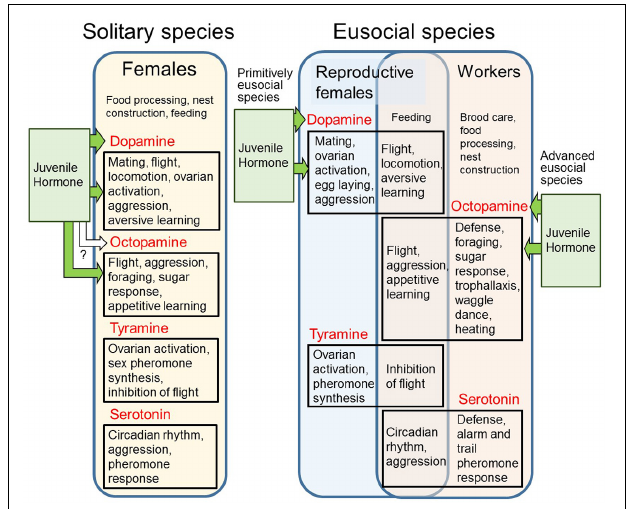
FIGURE 4 | Decoupling the multiple roles of biogenic amines into each phenotype in eusocial species. Multiple roles of biogenic amines in solitary and eusocial species are presented. Several general behaviors or movements are shared between both reproductive females and workers in eusocial species (overlapping area). Juvenile hormone regulates dopamine in solitary and primitively eusocial species, whereas it regulates octopamine in advanced eusocial